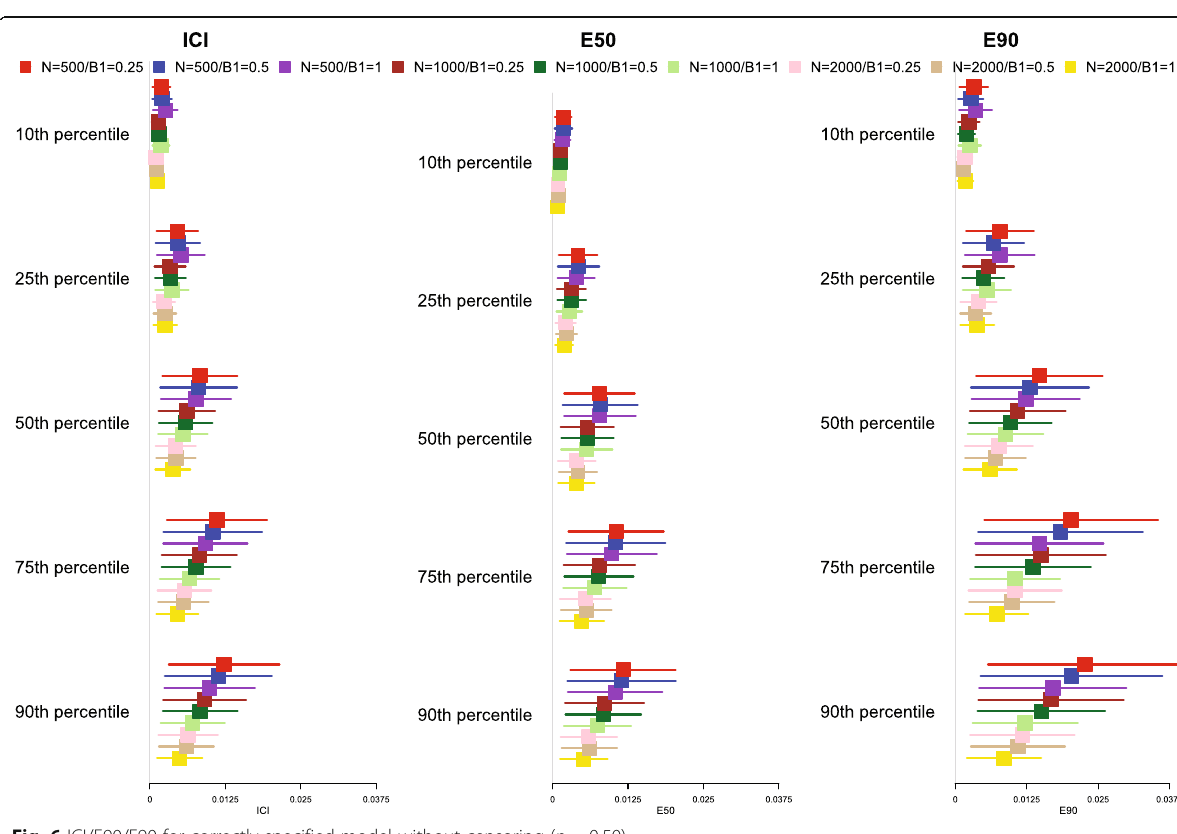
Fig. 6 ICI/E90/E90 for correctly specified model without censoring ( p =